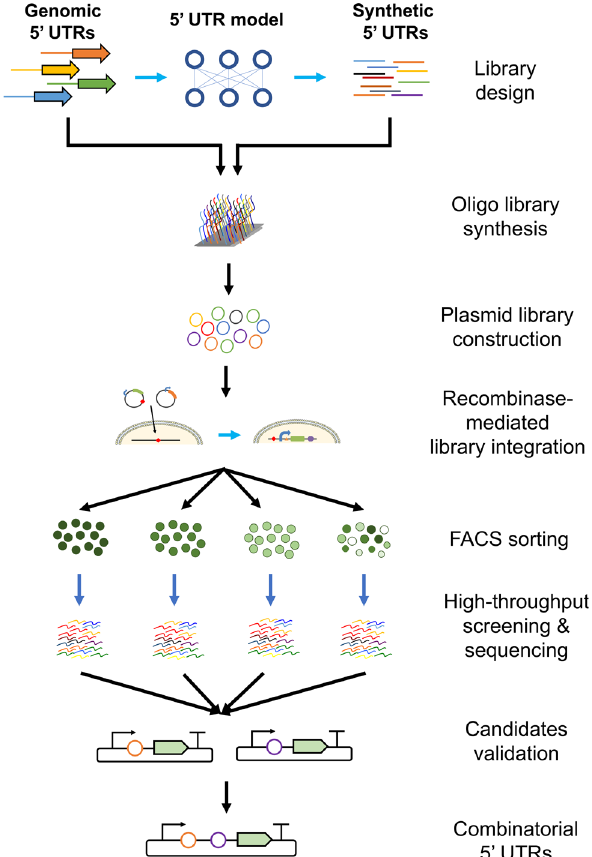
Fig. 1 Schematic overview of recombinase-mediated 5 ′ UTR library screening strategy. Naturally occurring 5 ′ UTRs were extracted, analyzed, and used as the training set to generate synthetic 5 ′ UTRs for screening. Oligos encoding the 5 ′ UTR library were synthesized and cloned into plasmids containing a recombinase-recognition site and a GFP reporter. The resulting plasmids were transfected into the HEK 293T-LP cell line with the corresponding recombinase recognition site, resulting in targeted genomic insertion. The cells were sorted into bins based on GFP intensities, and the 5 ′ UTR sequences of each bin were ampli fi ed, sequenced, counted, and compared. The 5 ′ UTR candidates that enhanced GFP expression were selected and validated experimentally. Finally, the top-ranked validated 5 ′ UTRs were combined to test for increased gene